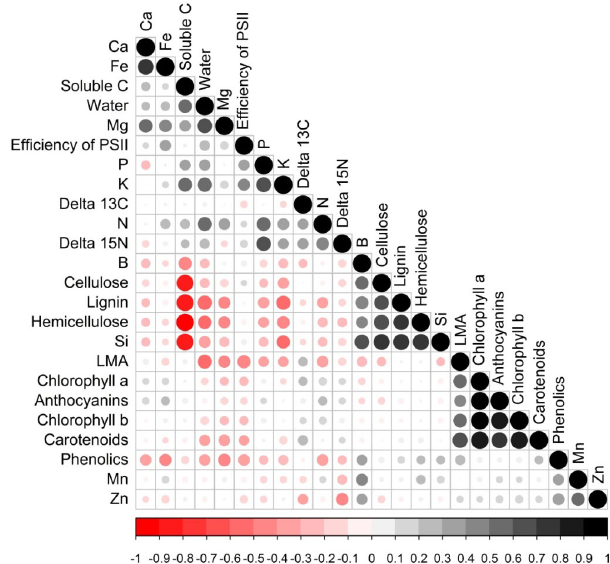
Figure 5. Partitioning of variance of foliar traits between species, soil, species–soil interaction and residual components for six gen- eralist species found on both chalk and alluvial soils from predicted data. Residual variation arises from within-site intraspecific vari- ation, microsite variability, canopy selection but not measurement error variance, and is therefore smaller than for field measurements (Fig. 1). Predicted data were obtained from partial least square re- gression